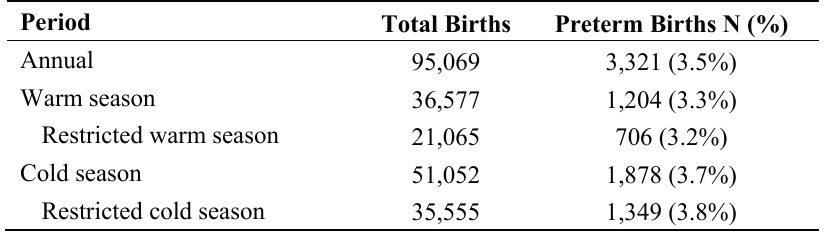
Table 1. Description of the distribution of total and preterm births included in the study per